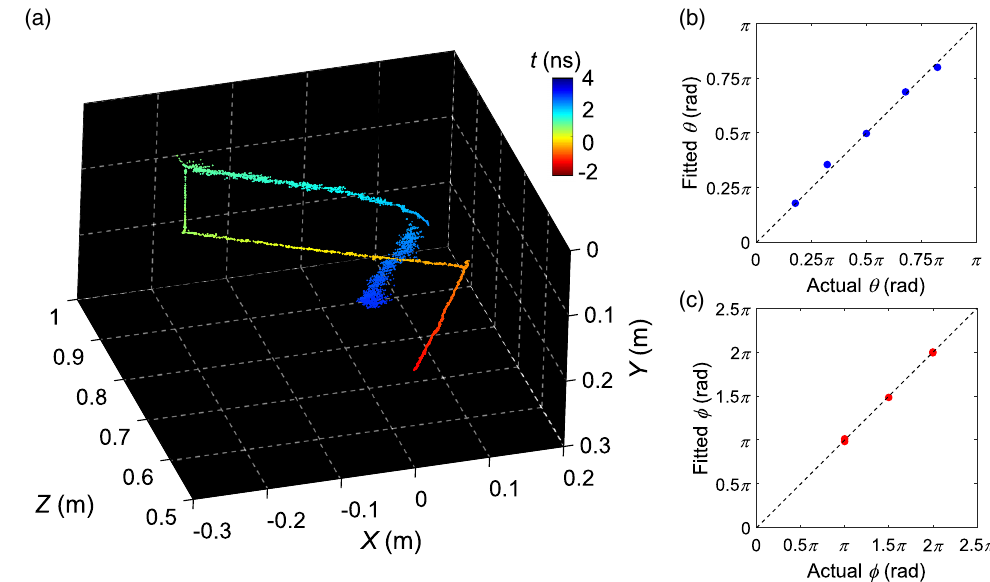
FIG. 4. Reconstructed four-dimensional light-in-flight observation. (a) Four-dimensional point cloud reproduced from the measured three-dimensional spatiotemporal data. The origin of the Cartesian coordinate system is defined at the optical center of the lens for the SPAD camera. The ( x , y , z , t ) coordinates of each data point are reproduced using the obtained fitting parameters for the corresponding data cluster. (b,c) Comparison of fitted light propagation angles θ and ϕ , respectively, with the actual angles for five data clusters. The fitted results show good agreement with the actual